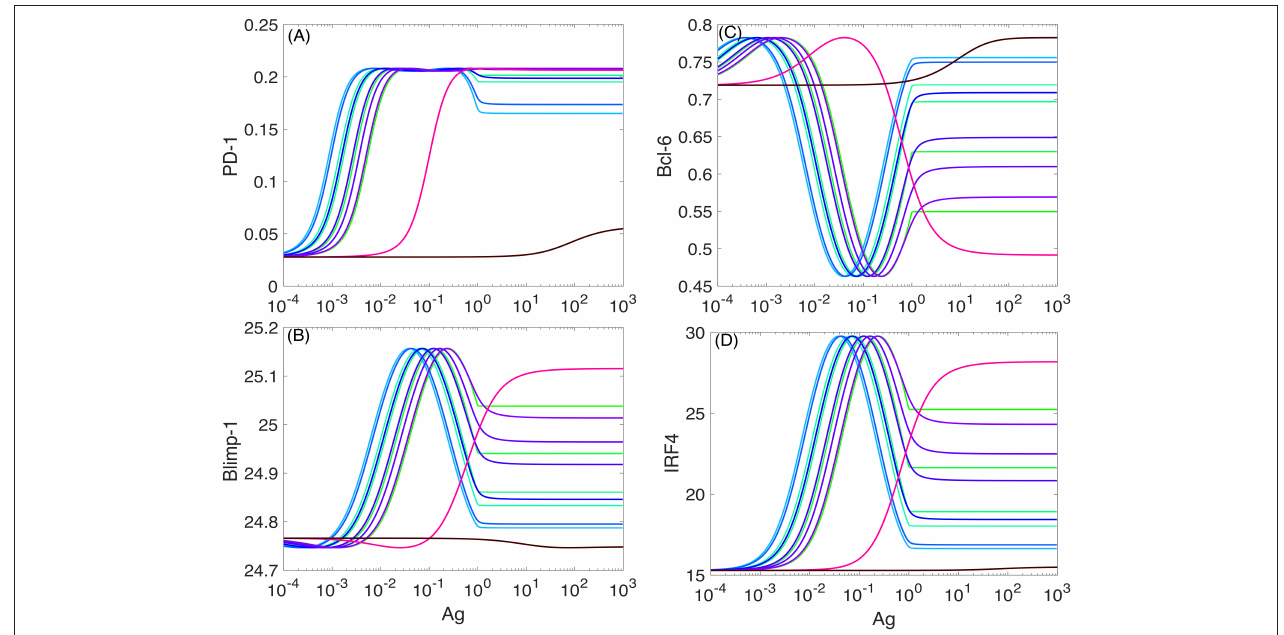
FIGURE 5 | PD-1 DIFFL responses in the absence of PD-1:PD-L1 interaction. The color-coded plots corresponds to the PD-1 DIFFL-induced adaptation with respect to increasing Ag-levels. To obtain a full adaptation, approximately a 10 3 -fold increase in the Ag-level is required. Four different (bottom-up) shades of green color correspond to k off = 10 − 4 , 2.03 × 10 − 4 , 4.13 × 10 − 4 , and 5.88 × 10 − 4 , respectively. Two shades of blue color correspond to k off = 2.43 × 10 − 3 and 7.01 × 10 − 3 , respectively. Four (top-down) shades of purple color correspond to k off = 2.03 × 10 − 2 , 4.13 × 10 − 2 , 5.88 × 10 − 2 , and 8.38 × 10 − 2 . Magenta color corresponds to k off = 1.0. Black color corresponds to k off = 49.24. (A–D) Correspond to the levels of four species, PD-1, Blimp-1, Bcl-6, and IRF4, computed from the model developed in SI2,